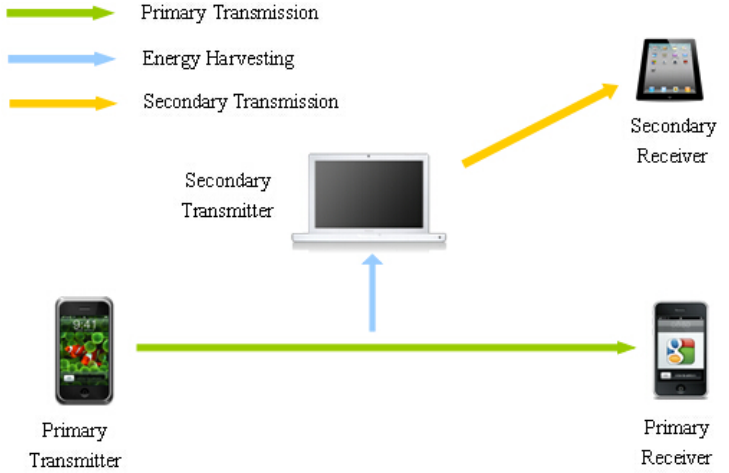
Figure 1. Timeslot structure between secondary user (SU) and primary user (PU) in cognitive radio (CR) systems.